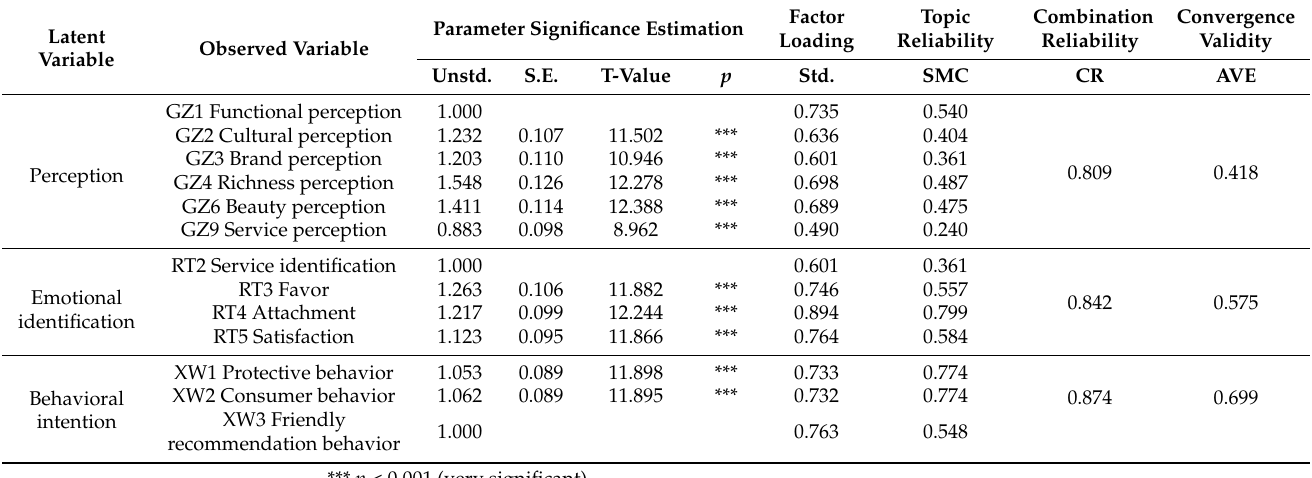
Table 5. The revised confirmatory factor analysis.